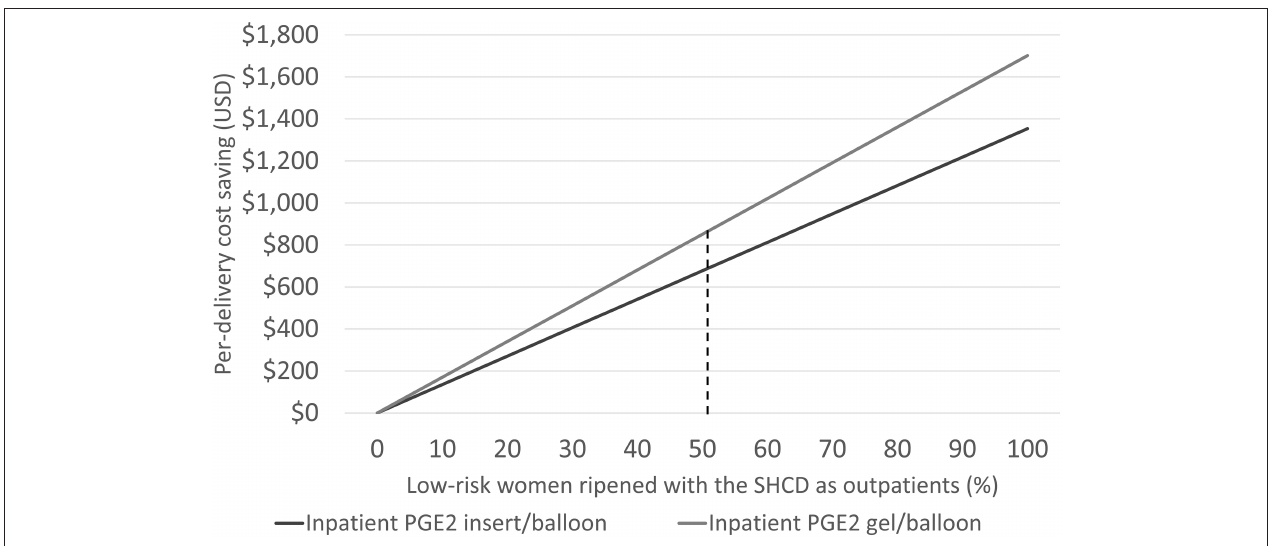
FIGURE 2 | Illustrating the cost-saving potential by increasing the number of low-risk women for outpatient cervical ripening with the synthetic hygroscopic cervical dilator (SHCD) from 0 to 100%. The dashed line represents the model base case at 50.9%.